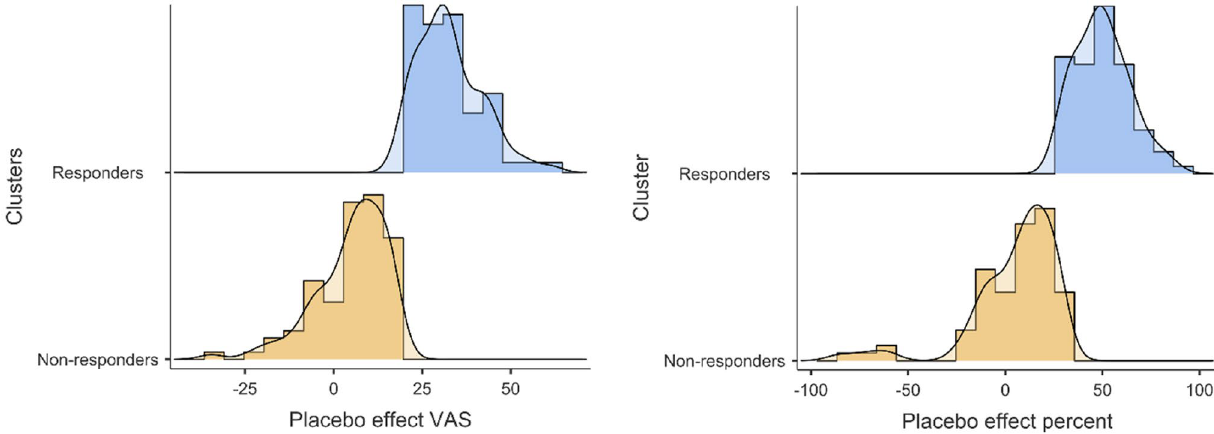
Figure 2. Histograms showing the distribution of responders and nonresponders classified by the two-step cluster and 5.16 (95% CI [2.98–7.33]), medians of 31 and 7.5, and modes of 29.5 and 3 for changes in VAS pain ratings. The cluster quality was good, with an average silhouette measure of .7. The two clusters were termed placebo responders (N = 65, 42%) and nonresponders (n = 90, 58%), respectively. The distribution of changes in pain for the responders and nonresponders is shown in Fig. 2, and the mean difference in pain changes between the responders and nonresponders was significant (t (153) = 17.19, p < .001). The effect size was very large 24 based on the mean difference between the responders and the nonresponders (32.68–5.16/SD 16.70 = 1.65; Cohen’s d ). To test the stability of the results from the two-step cluster analysis, the order of the sample was randomized again and split into halves and then run in two separate samples. When splitting the sample, the results were identical to the initial analysis with two clusters and a silhouette measure of .7. The cluster solution with two clusters was additionally tested in a supervised k -means cluster analysis. The k -means analysis showed that a two-cluster solution produced the same number of responders (N = 65), and nonresponders (N = 90), the two clusters had final cluster centers of 32.68 and 4.88, and the ANOVA test for differences in cluster means was significant (F (1, 153) = 295.54, p < .001). When performing the two-step cluster analytic procedure on data from the control group, four clusters emerged with good quality of the clusters (.7) determined by the average silhouette measure (cluster 1, N = 23, mean = 20.8; cluster 2, N = 42, mean = 8.83; cluster 3, N = 50, mean = − .09; cluster 4, N = 26, mean = − 13.13).